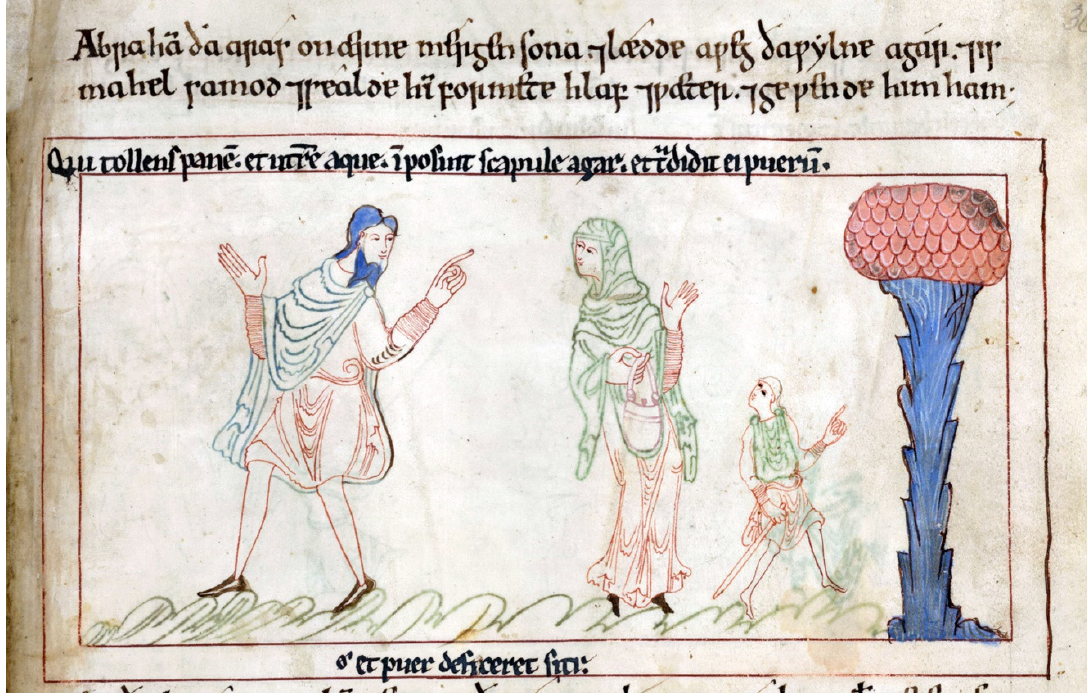
Figure 2. Canterbury Hexateuch , ca. 1025–1049. London, British Library, Cotton Claudius B IV, f. 36r.